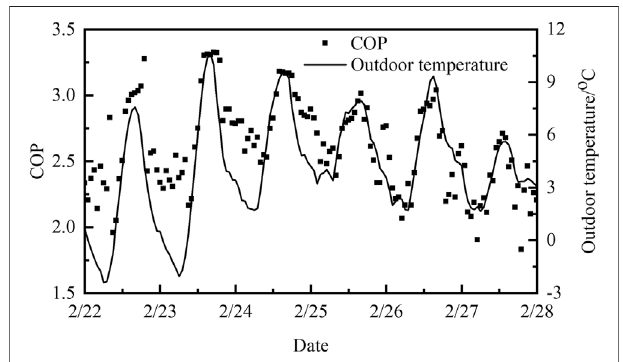
FIGURE 9 | Hourly COP of the system during the test period.